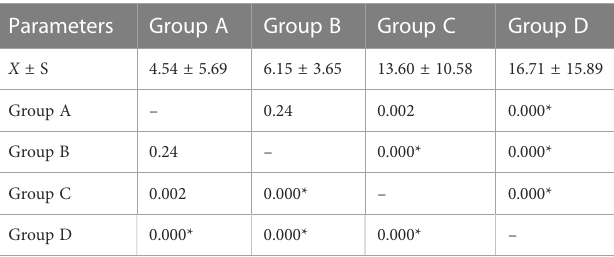
TABLE 3 Treatment protocols correlated with OS of 80